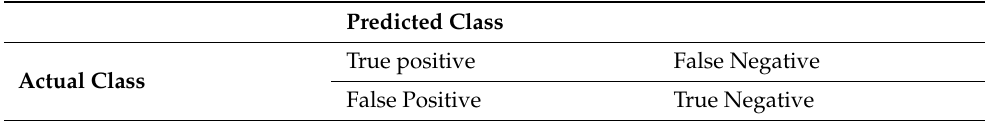
Table 2. Confusion Matrix for different